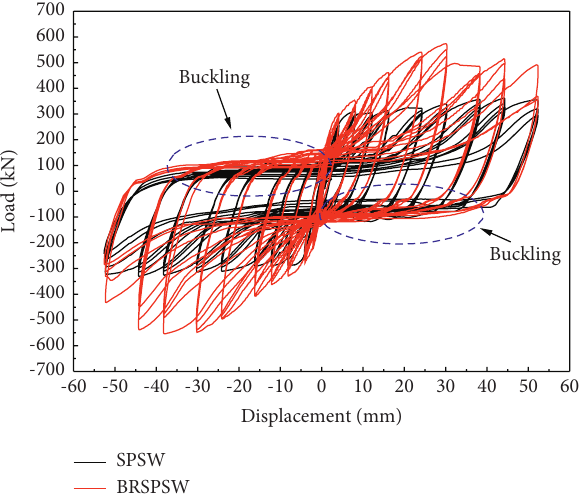
Figure 15: Hysteretic curves of both